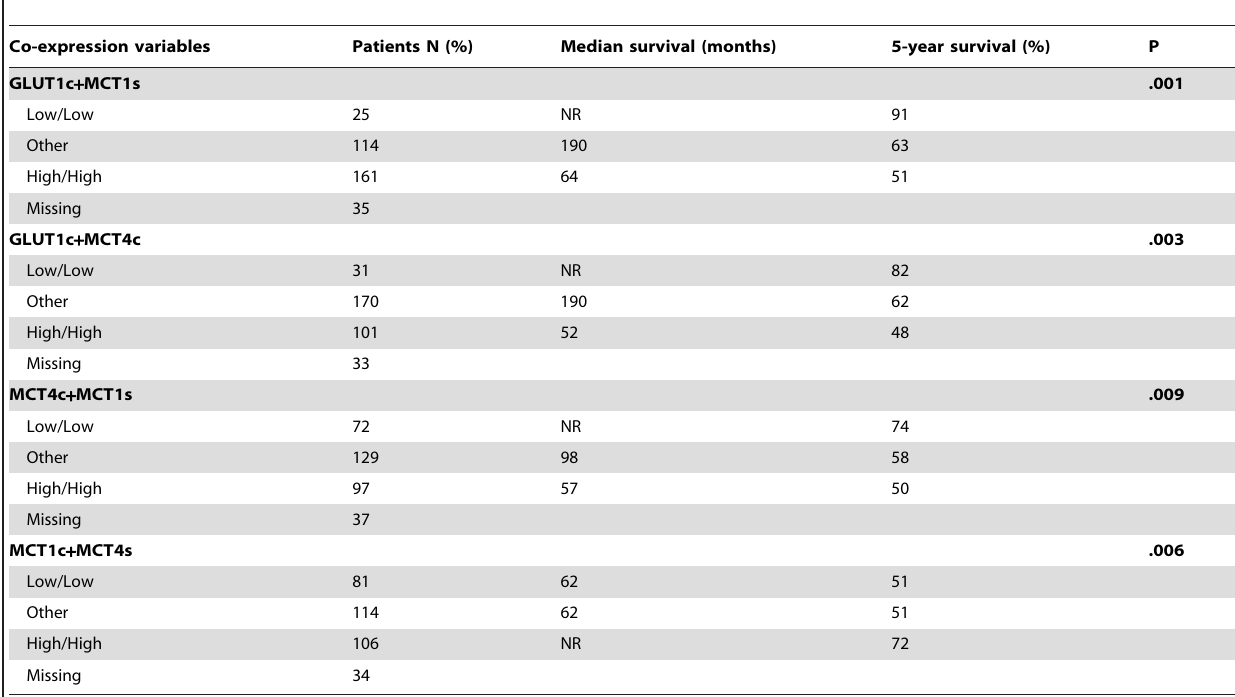
Table 3. Metabolic co-expression variables in cancer and stromal cells as predictors of disease-specific survival in 335 NSCLC patients (univariate analyses; log-rank